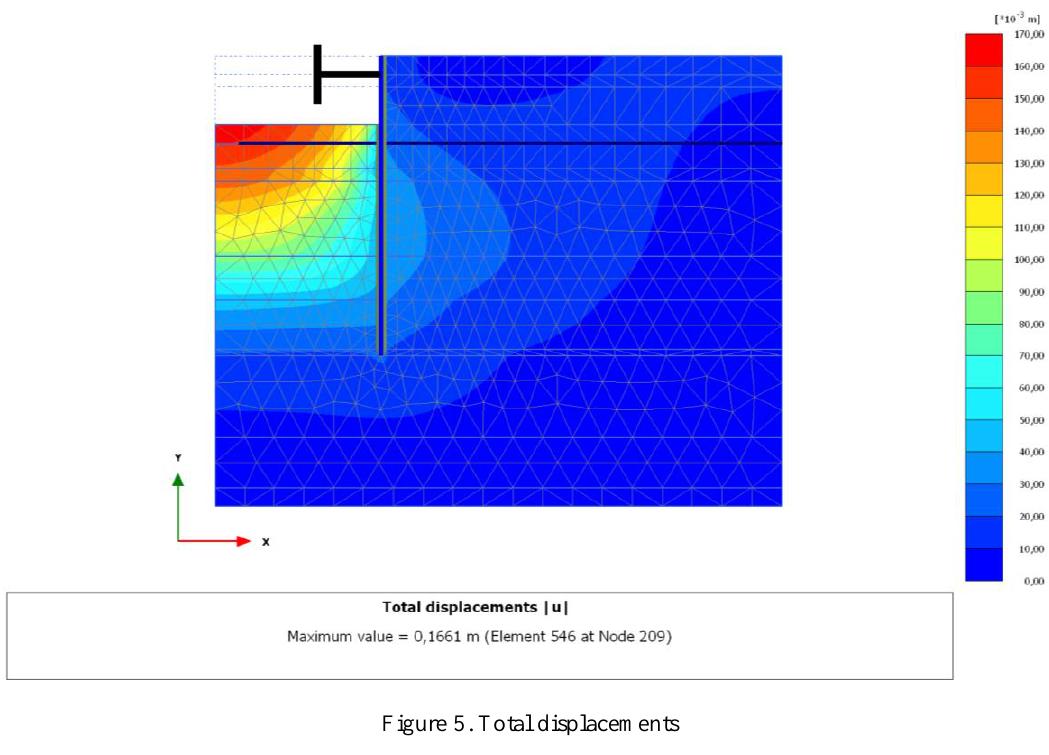
Figure 5. Total displacements